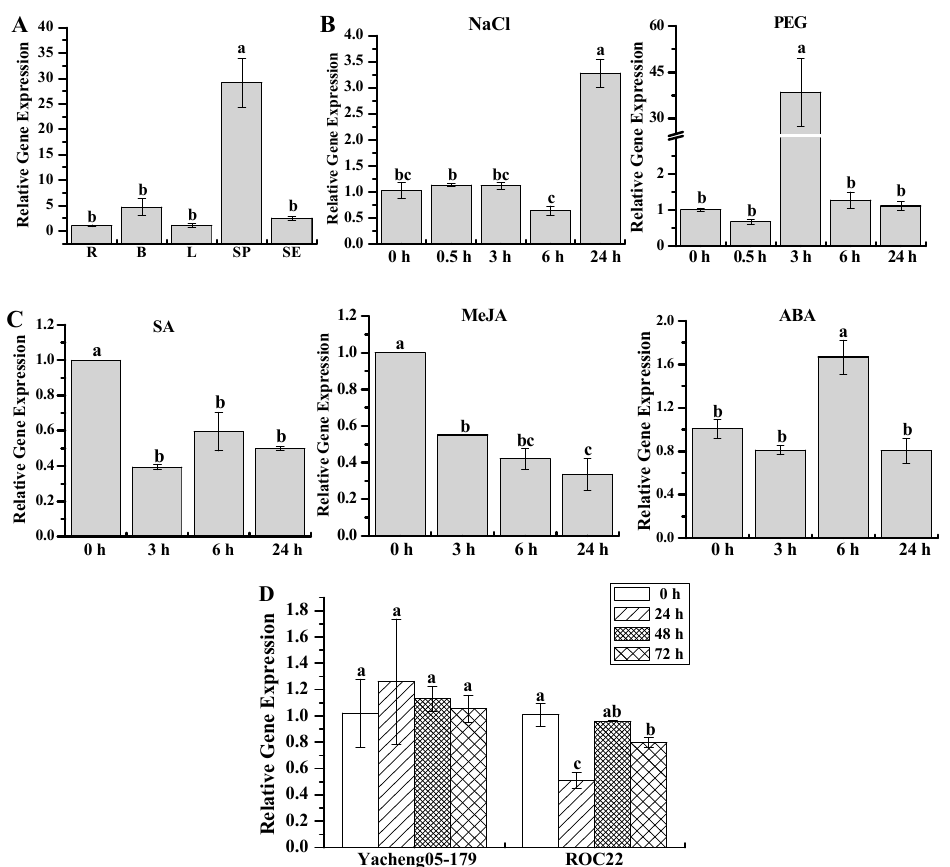
Figure 7. Gene expression assay of ScWRKY3 . (A) Tissue-specific expression analysis of ScWRKY3 in different 10-month-old ROC22 tissues by qRT-PCR. The tissues (root, bud, leaf, stem pith, and stem epidermis) are represented by R, B, L, SP, and SE, respectively. (B) Gene expression patterns of ScWRKY3 in 4-month-old ROC22 plantlets under abiotic stress. NaCl, sodium chloride (simulating salt stress) (250 mM); PEG, polyethylene glycol (simulating drought treatment) (25.0%); (C) Gene expression patterns of ScWRKY3 in 4-month-old ROC22 plantlets under plant hormone stress. SA, salicylic acid (5 mM); MeJA, methyl jasmonate (25 μ M); ABA, abscisic acid (100 μ M). (D) Gene expression patterns of the ScWRKY3 gene after infection with smut pathogen. Yacheng05-179 is a smut-resistant Saccharum hybrid cultivar, and ROC22 is a smut-susceptible Saccharum hybrid cultivar. Data are normalized to the glyceraldehyde-3-phosphate dehydrogenase ( GAPDH ) expression level. All data points are means ± standard error ( n = 3 ). Bars superscripted by different lowercase letters indicate significant differences, as determined by Duncan’s new multiple range test (p-value < 0.05).